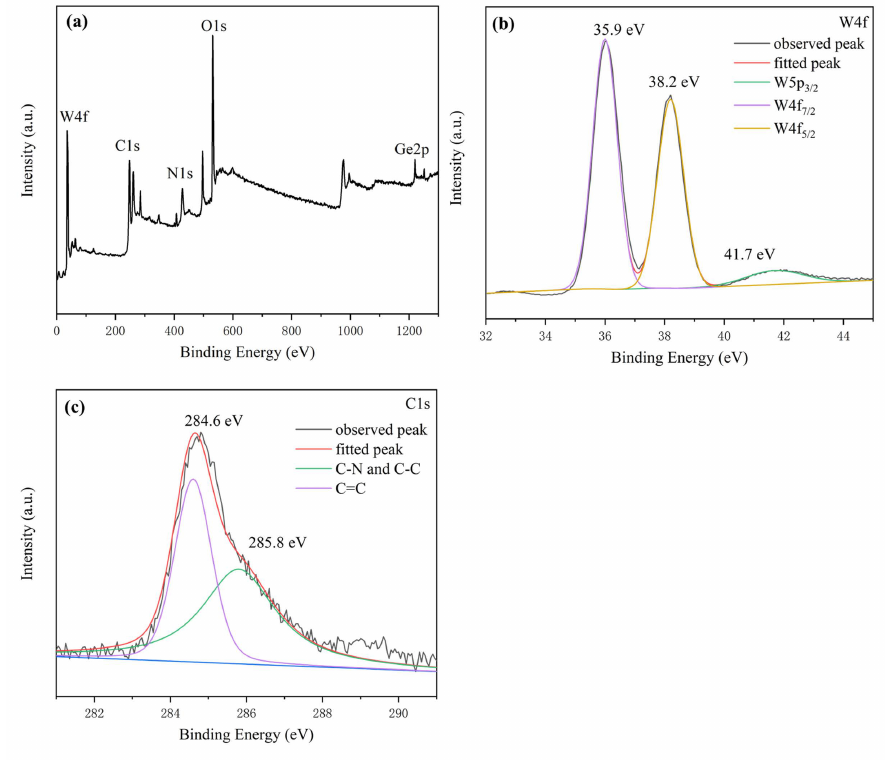
Figure 4. XPS spectra of H 4 GeW 12 O 40 (( a ) survey spectrum; ( b ) W; ( c ) C.).